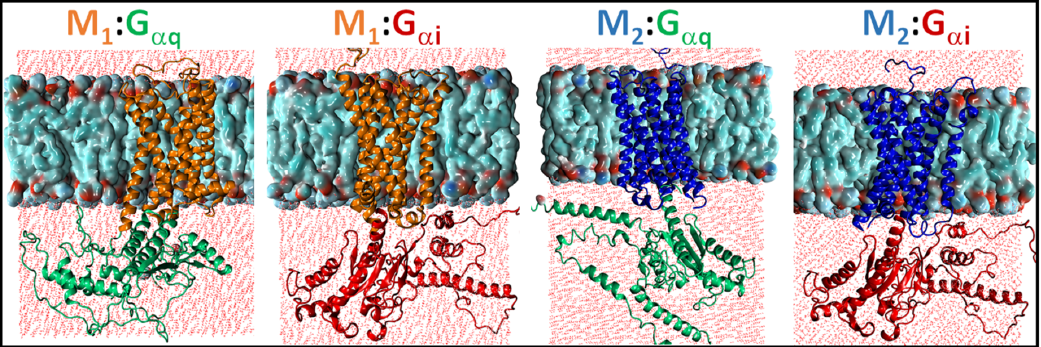
Figure 2. The four receptor–G protein complexes embedded in the membrane environment. The M1 receptor is shown in orange. The M2 receptor is shown in blue. The Gαq protein is shown in green and the Gαi protein is shown in red. The lipids are shown in space-filling representation and the two layers of water molecules above/below the lipid bilayer are shown in red.